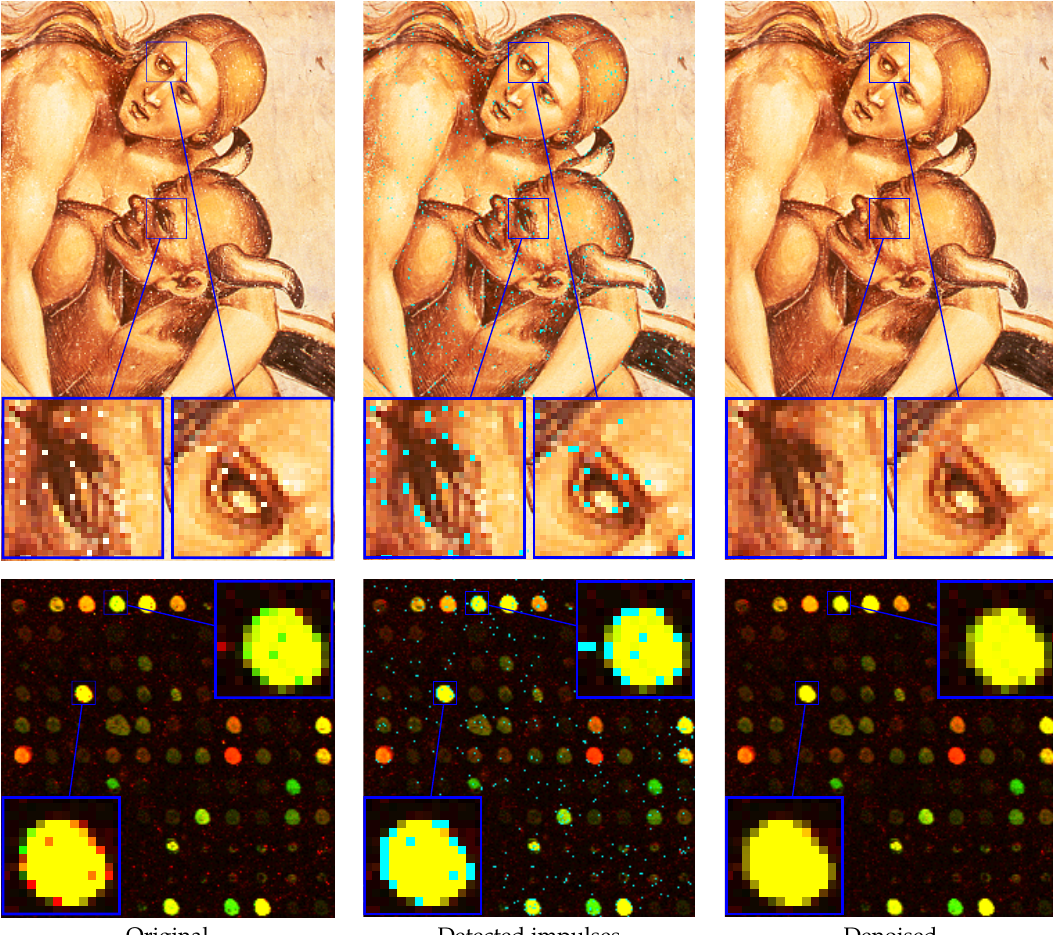
Figure 15. Denoising result of the proposed IDCNN filter on real noisy images: a part of an image of the fresco “The Condemned in Hell” by Luca Signorelli ( top ) and cDNA image ( bottom ). Detected impulses are annotated using cyan color.